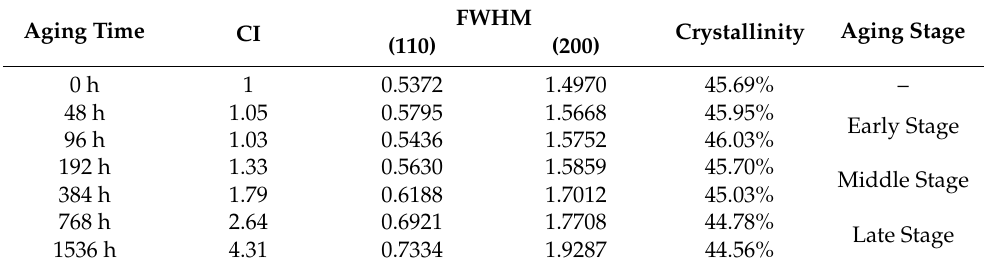
Table 1. CI, XDR data of each aging